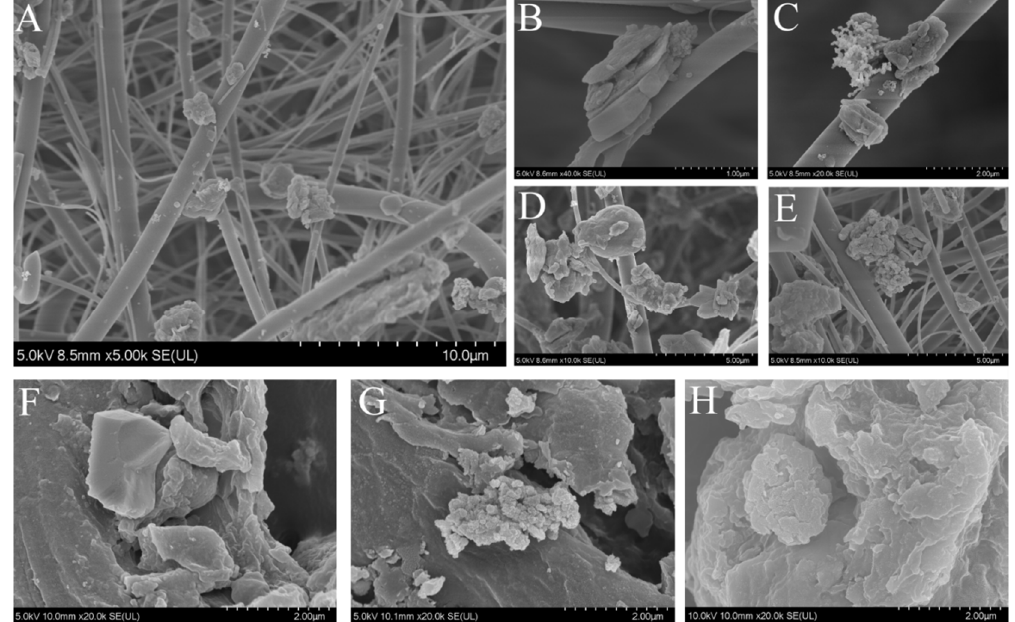
Figure 2. Microscopic morphology of particulate matter with an aerodynamic diameter of less than 2.5 μ m (PM 2.5 ), feed, manure, and dust. ( A – E ): The morphology of PM 2.5 particles. ( F , G , H ): electron micrographs of feed, manure, and dust particles.